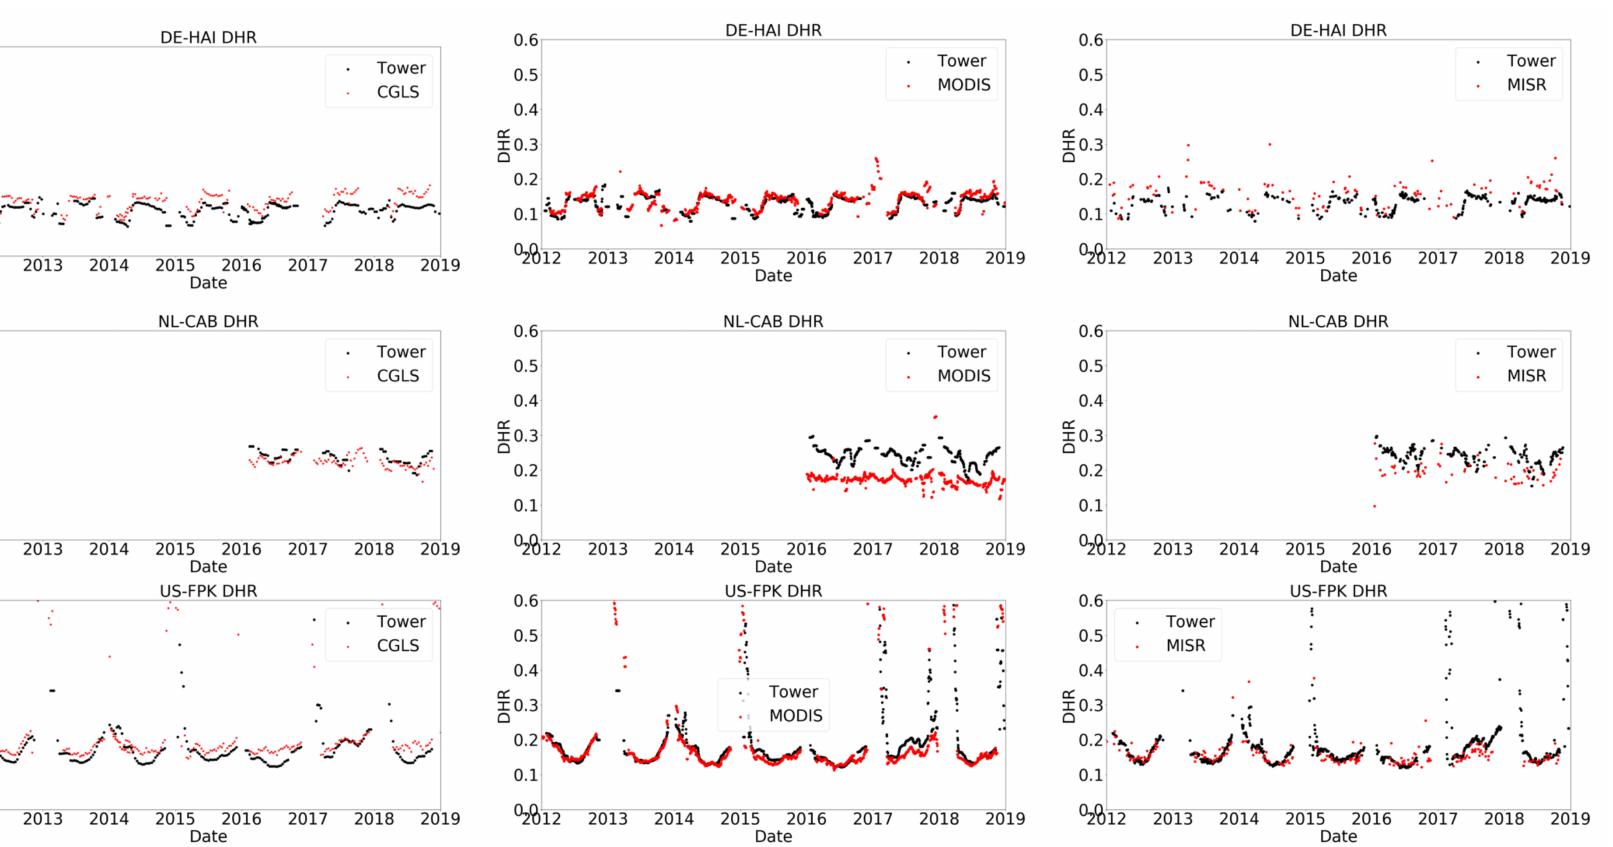
Figure 12. Intercomparison of DHR values derived from in situ tower measurements and coarse-resolution satellite products at the DE-HAI, NL-CAB and US-FPK sites. Copernicus Global Land Service (CGLS) values are depicted in the first column, moderate resolution imaging spectroradiometer (MODIS) values are depicted in the second column and multi-angle imaging spectroradiometer (MISR) values are depicted in the third